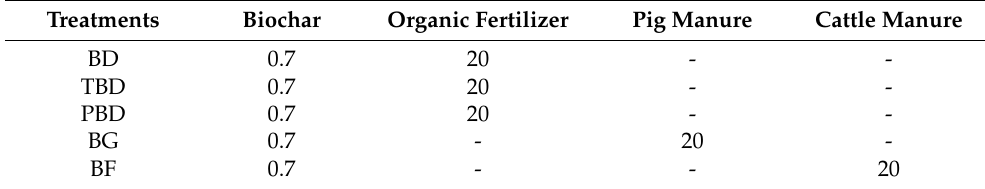
Table A1. Settings for each treatment.